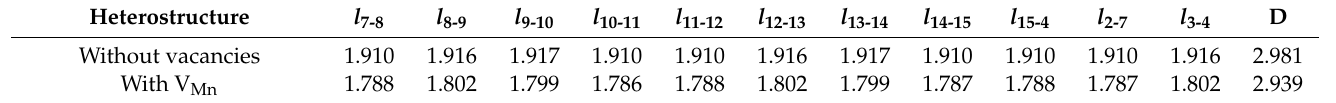
Table 1. Bond lengths (in Å), for the atoms closest to V O and interfacial distance D (in Å). Heterostructure l 1-2 Without vacancies With V O Table 2. Bond lengths (in Å), for the atoms closest to V Mn and interfacial distance D (in Å).